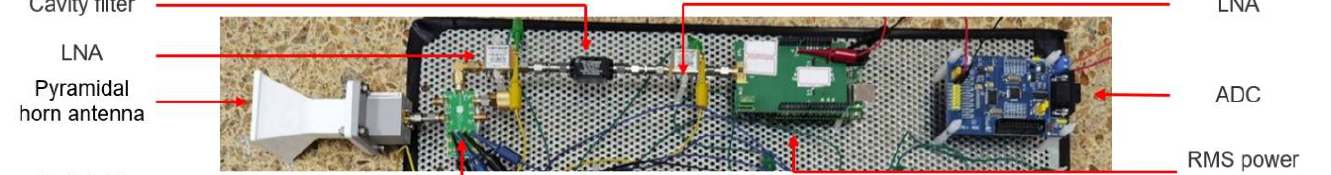
Figure 8. Full-power microwave temperature radiometer prototype.